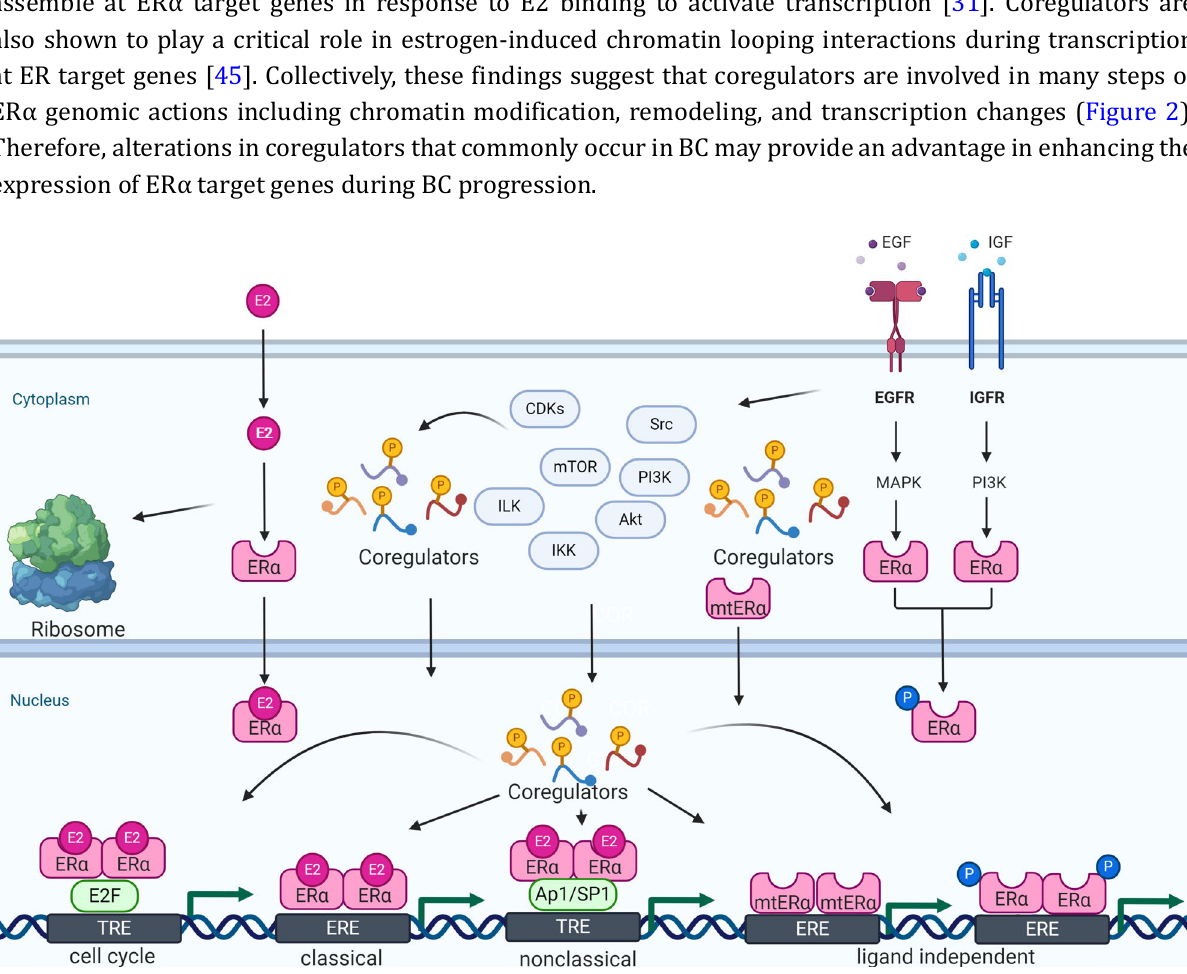
Explor Target Antitumor Ther. 2021;2:385-400 | https://doi.org/10.37349/etat.2021.00052